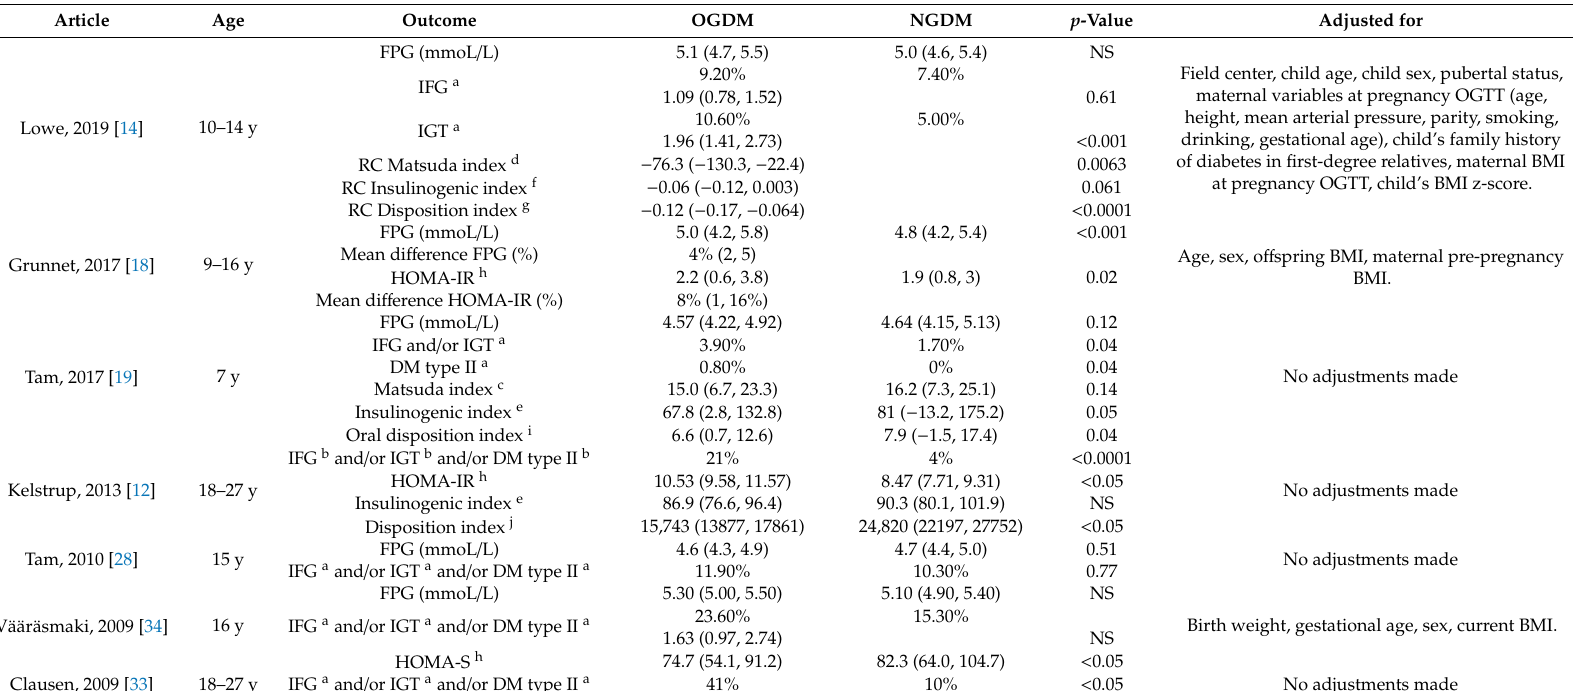
Table 3. The impact of GDM on glucose intolerance and insulin resistance in the o ff